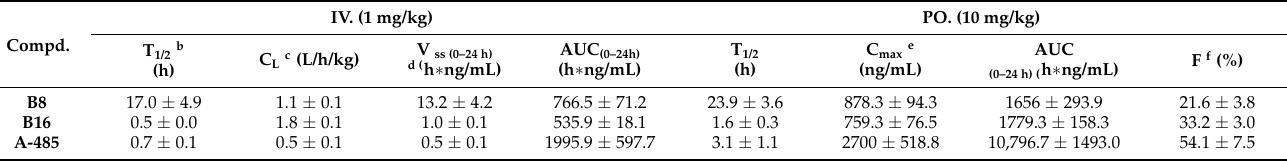
Table 3. Pharmacokinetic profiles of selected compounds a .